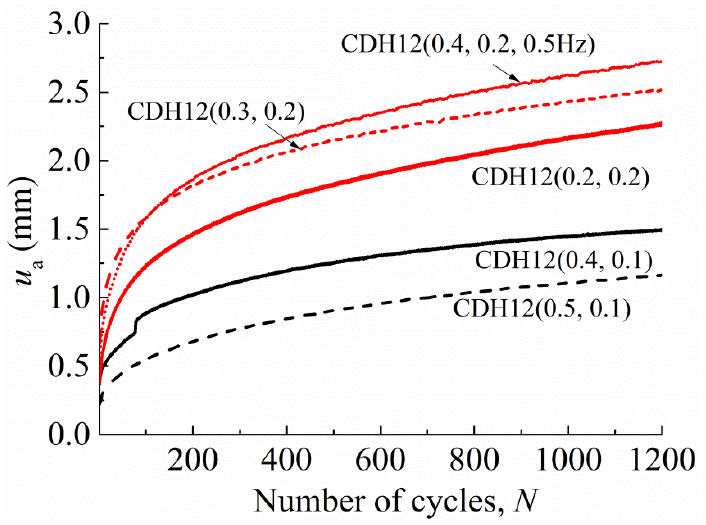
Figure 11. Developments of accumulated displacement under different mean cyclic loads.